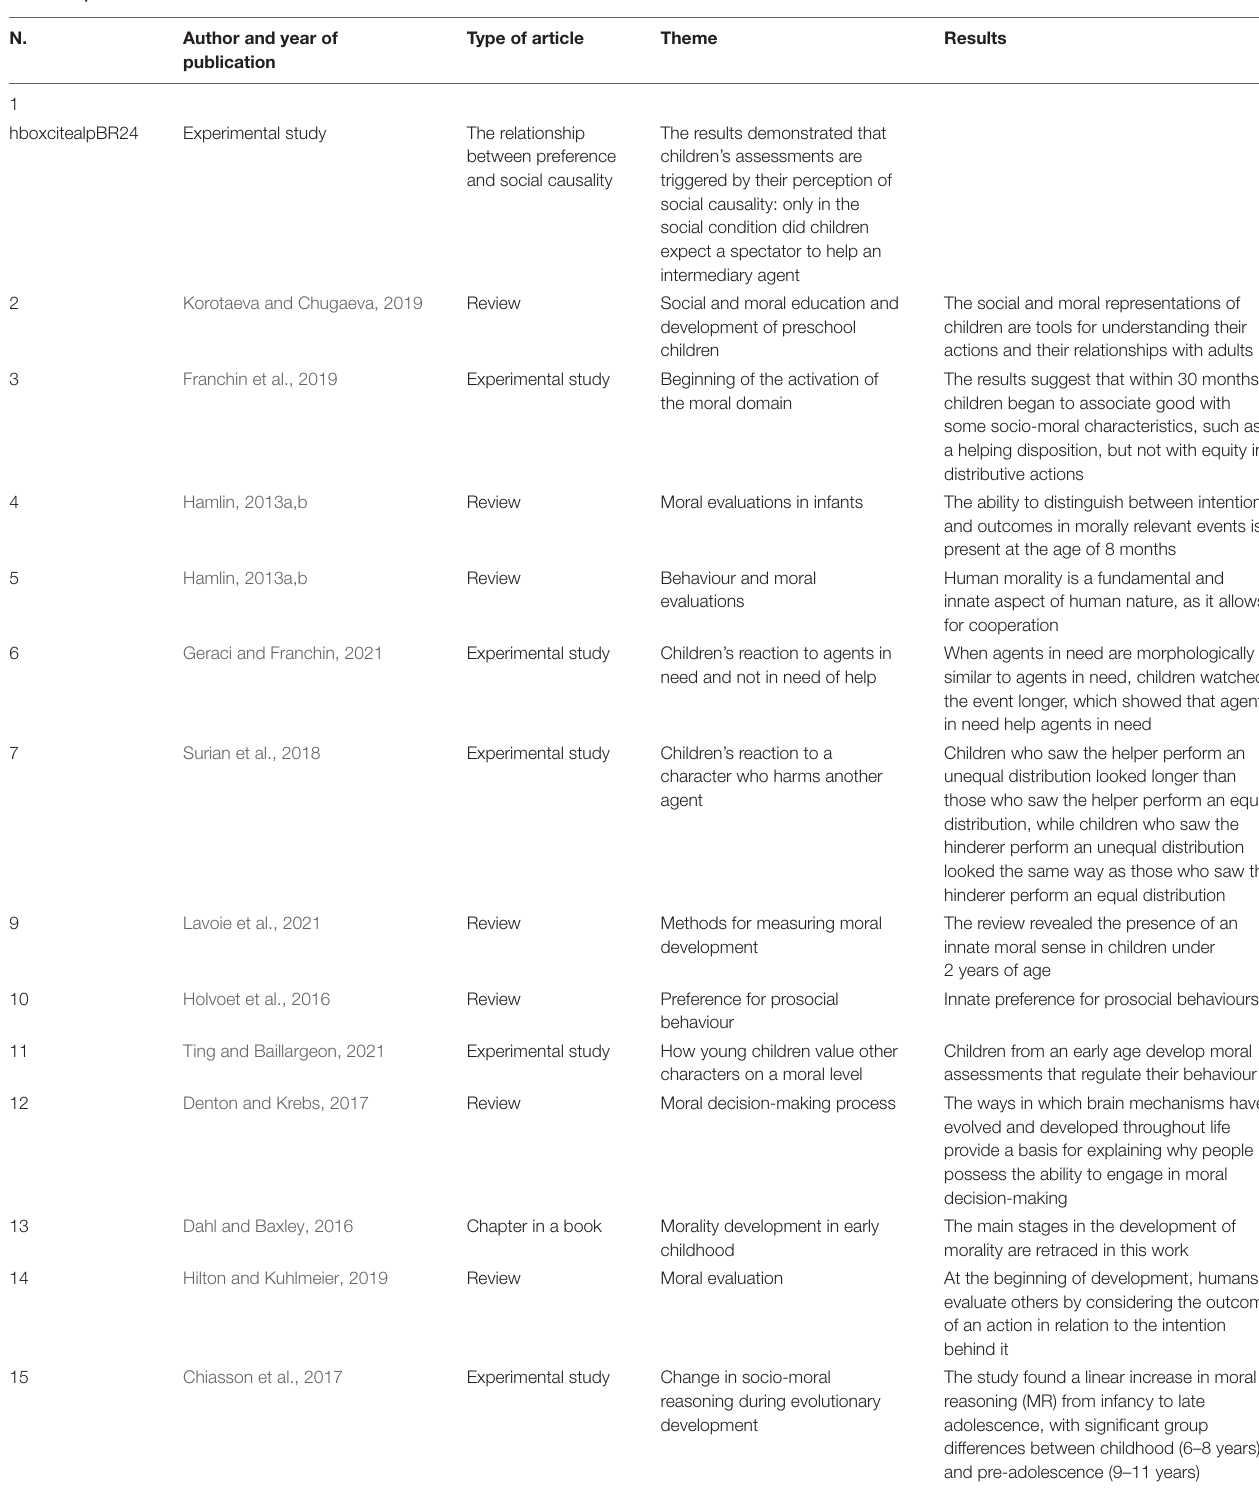
TABLE 1 | Overview of reviewed studies.